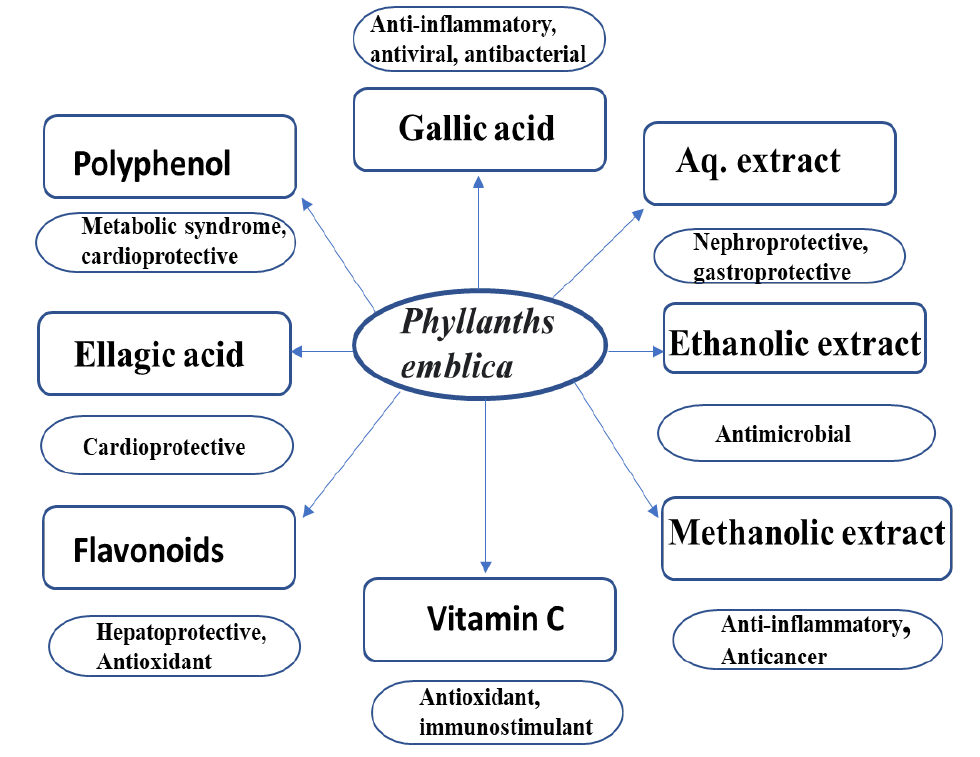
Figure 6. Phytochemicals and properties of